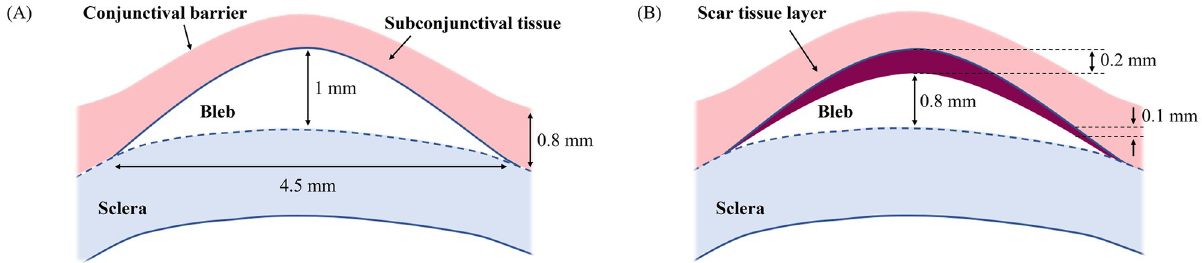
Fig 3. Two-dimensional geometry of the filtering bleb. ( A ) Shape and dimensions of a healthy bleb and overlying conjunctival/Tenon’s tissue based on a cross-sectional Optical Coherence Tomography (OCT) image (patient with an IOP of 10 mmHg); these dimensions were used to simulate the normal (healthy/well-functioning bleb) and hypotony cases. ( B ) Shape and dimensions of the bleb, scar tissue layer, and subconjunctival tissue used to simulate the bleb scarring scenario.